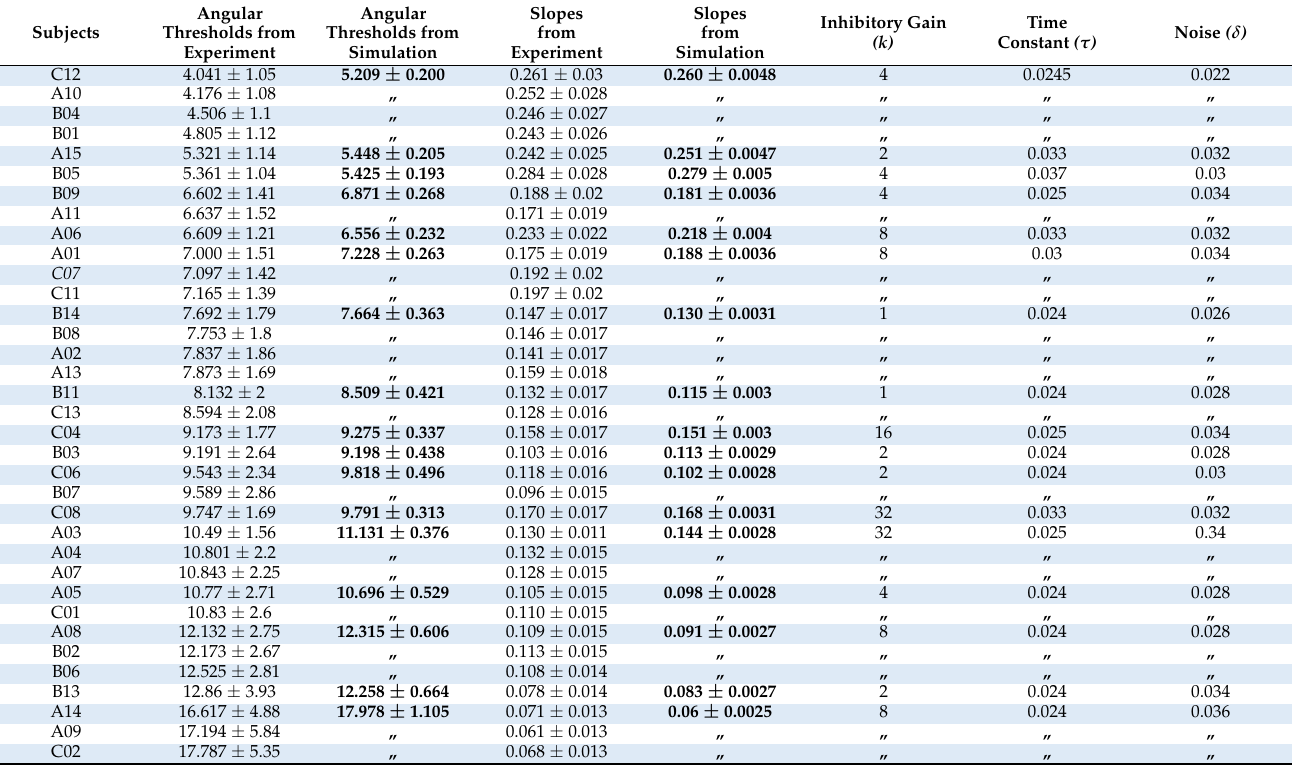
Table 1: by tuning the k , τ and δ Parameters the angular thresholds (75%) and the slopes of athletes’ psychometric functions have been simulated (symbol „ indicates that the quantity in that placeholder is the same as the quantity above it).